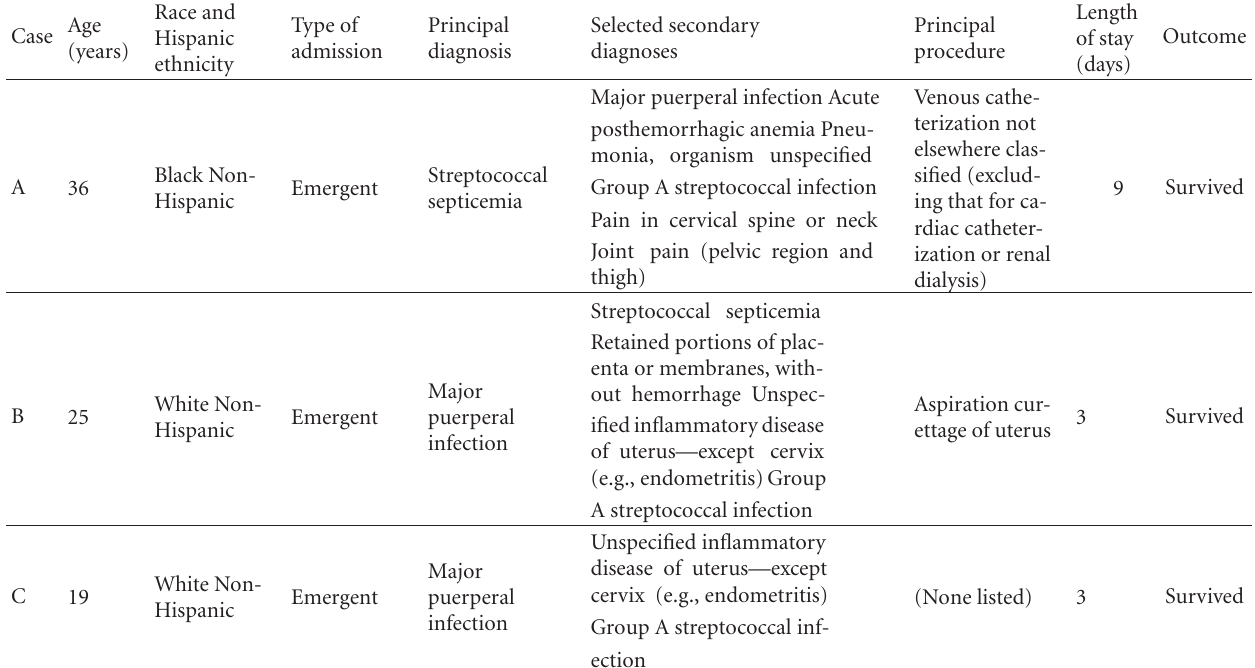
Table 2: Clinical and demographic characteristics of women discharged in 2001 in Florida with ICD-9-CM codes ∗ indicating the occurrence of a postpartum invasive group A streptococcal